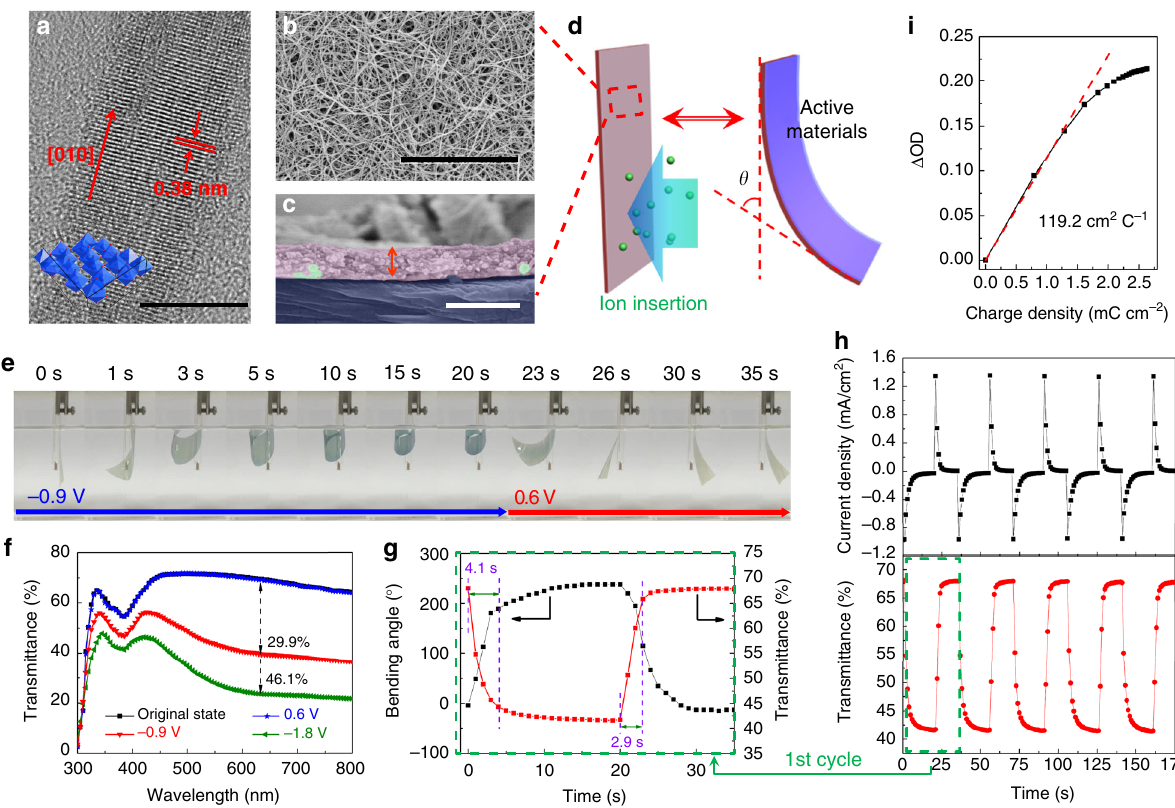
Fig. 1 The dual-responsive performances of as-prepared composite fi lms. a High-resolution transmission electron microscopy (HRTEM) image of a single W 18 O 49 nanowire (W 18 O 49 NW) (Scale bar: 10 nm); Field emission scanning electron microscopy (FE-SEM) images of b surface (Scale bar: 3 μ m) and c cross-section (Scale bar: 500 nm) of the dual-responsive fi lm; d Schematic illustration of measurement criteria of electrode deformation angles during